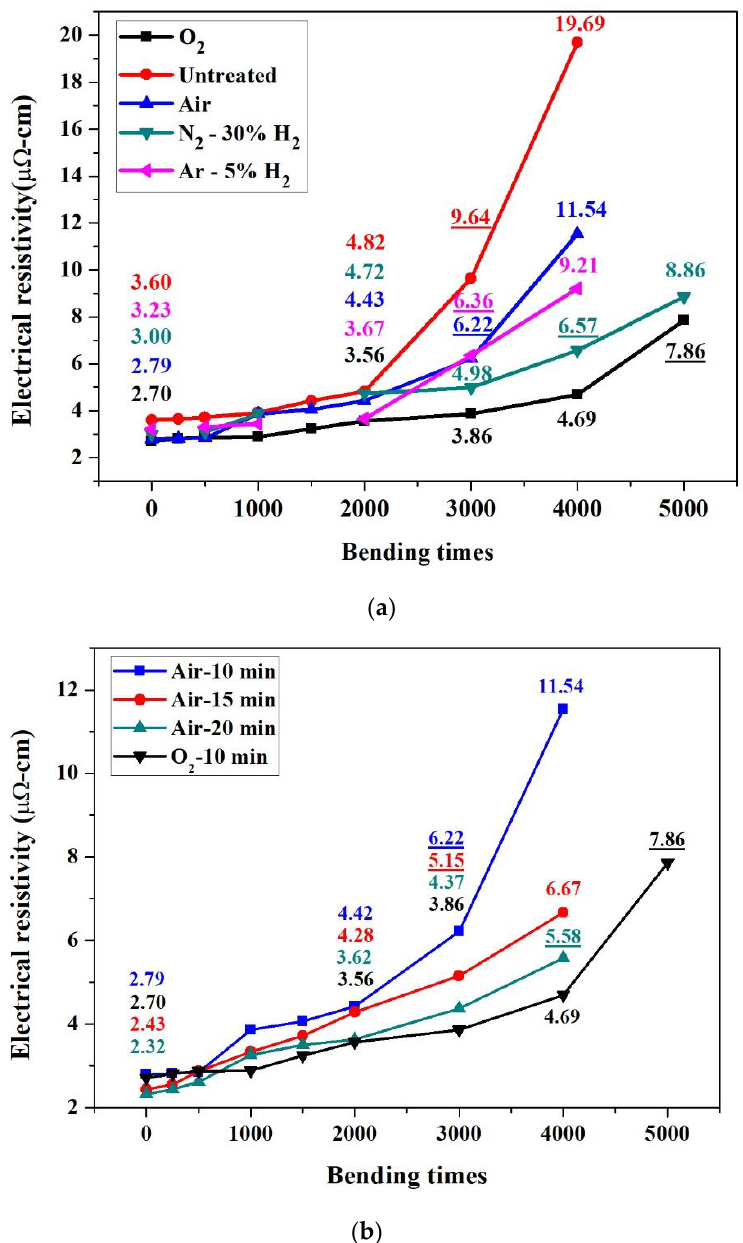
Figure 6. The relationship between the number of bends for test pieces and their respective electrical resistivity: ( a ) substrates modified using different plasmas, and ( b ) substrates modified by O 2 plasma, and air plasma with different processing periods.